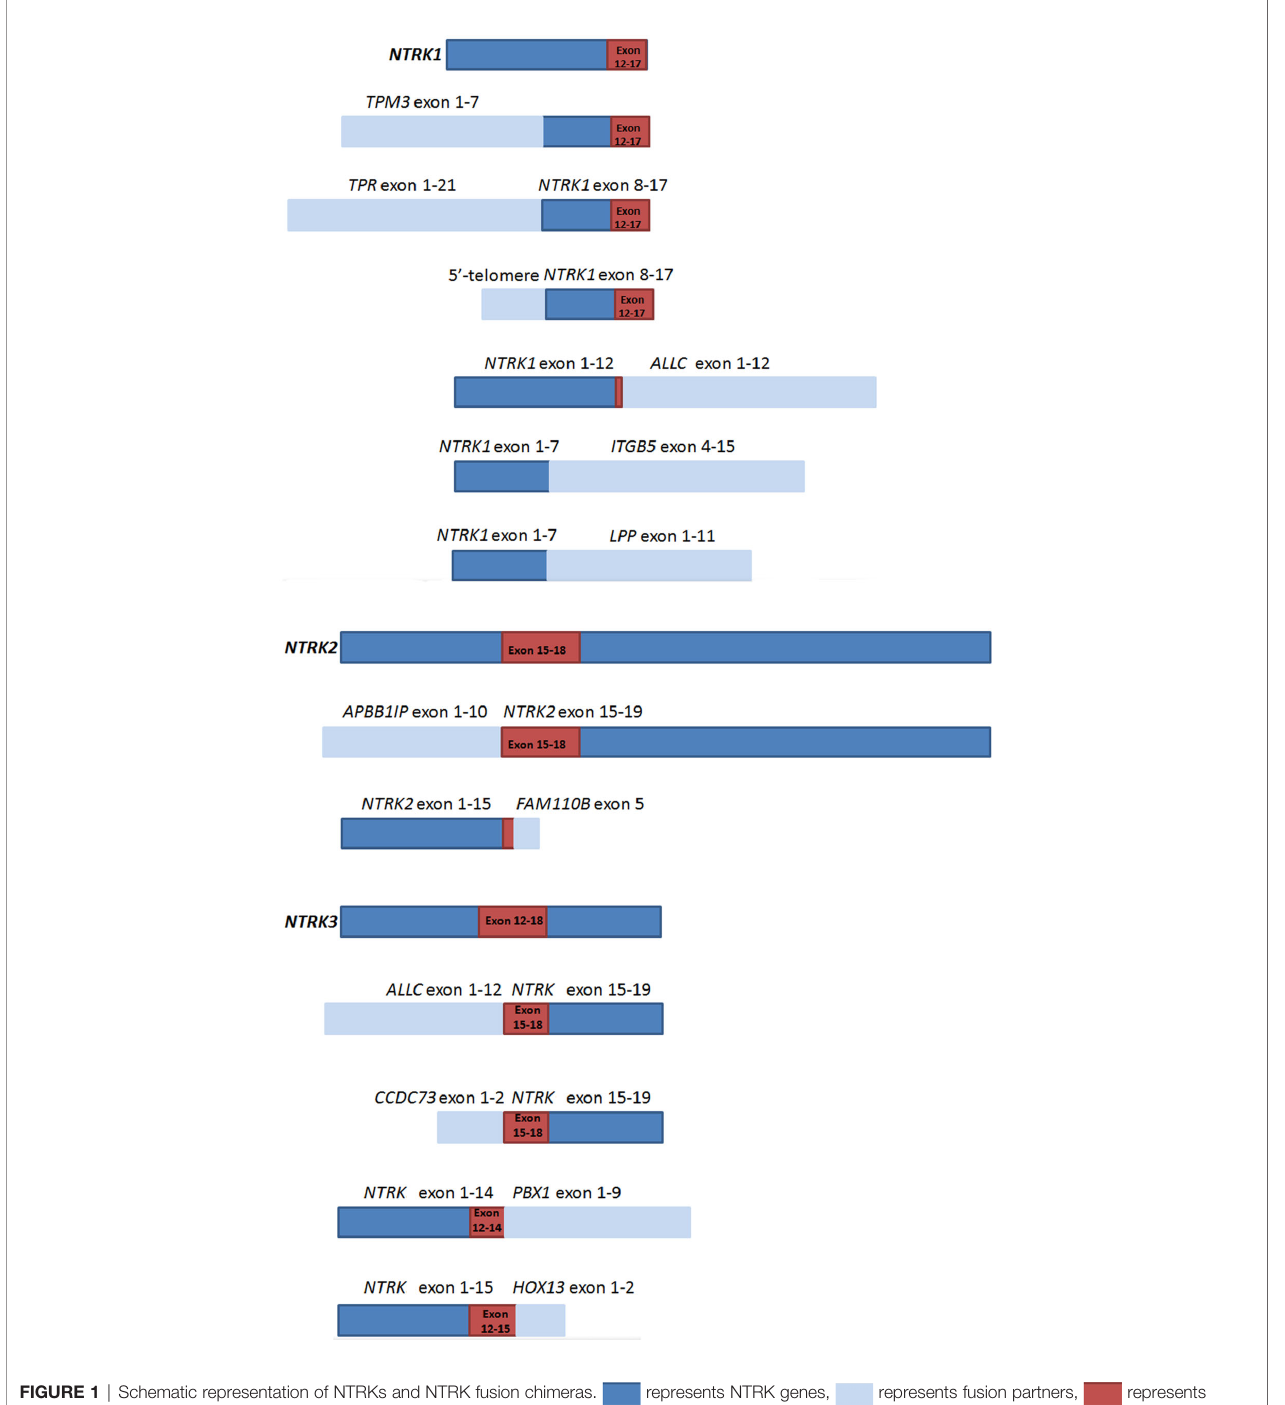
FIGURE 1 | Schematic representation of NTRKs and NTRK fusion chimeras. represents NTRK genes, represents fusion partners, represents domains that encode the tyrosine kinase of